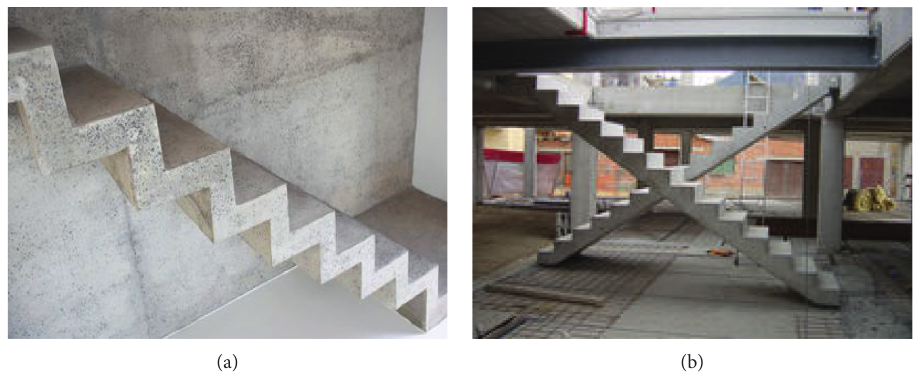
Figure 15: (a) Thin and (b) precast r.c. structures (stairs in this